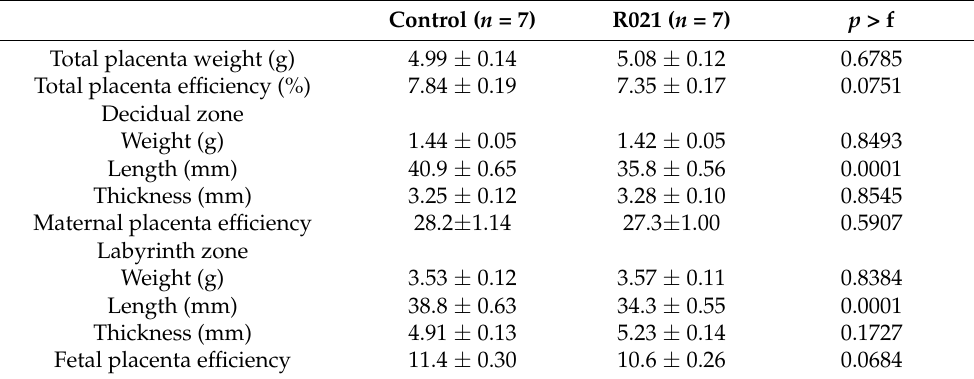
Table 3. Placenta morphometric characteristics and efficiency on Day 28 of gestation of ad libitum (Control group) and fed restricted females (105 g/day) during the first two-thirds of gestation and re-fed ad libitum until term (R021 group). Day 0, day of artificial insemination (AI); length gestation, 31 days.